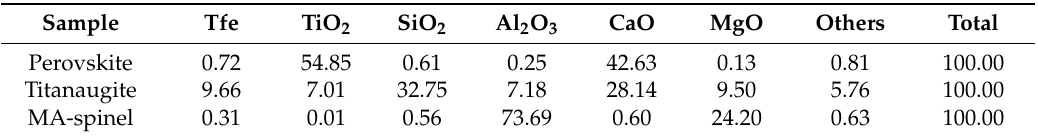
Table 1. Chemical compositions of perovskite, titanaugite, and MA-spinel analyzed by EDX (mass fraction,